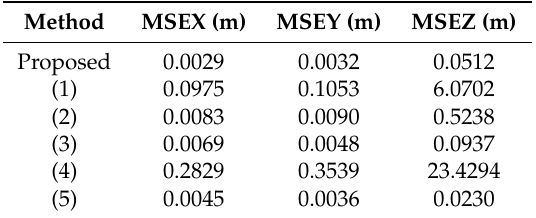
Table 5. Total Mean Squared Error of the estimated relative position of Quad 1 with respect to the